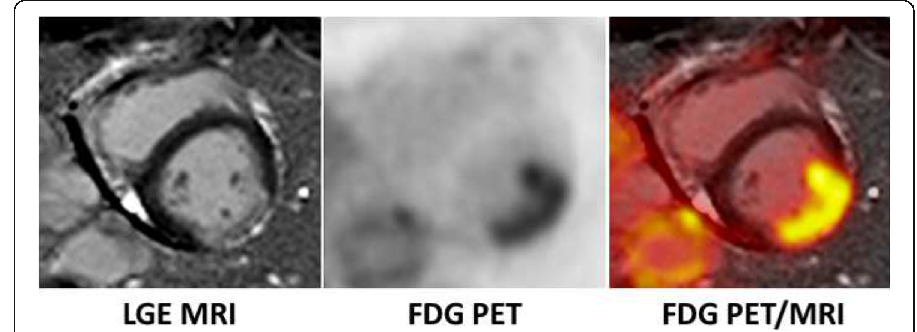
Fig. 7 Hybrid 18 F-FDG PET/MRI (suppressed myocardial glucose metabolism) early after ST-elevation myocardial infarction. LGE MRI (left panel) demonstrates myocardial infarction scar of the lateral wall. On FDG PET (middle panel), an intense FDG uptake matching the scar (right panel) is observed. The glucose metabolism in the scar indicates a florid inflammatory response after myocardial